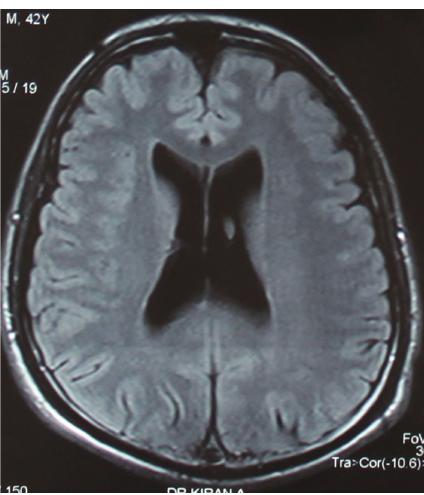
Figure 2: Post-ECT cranial noncontrast magnetic resonance imaging showing bilateral asymmetric extensive acute subdural hematoma extending over right frontoparietal and left parietal areas with mass e ff ect and midline shift to